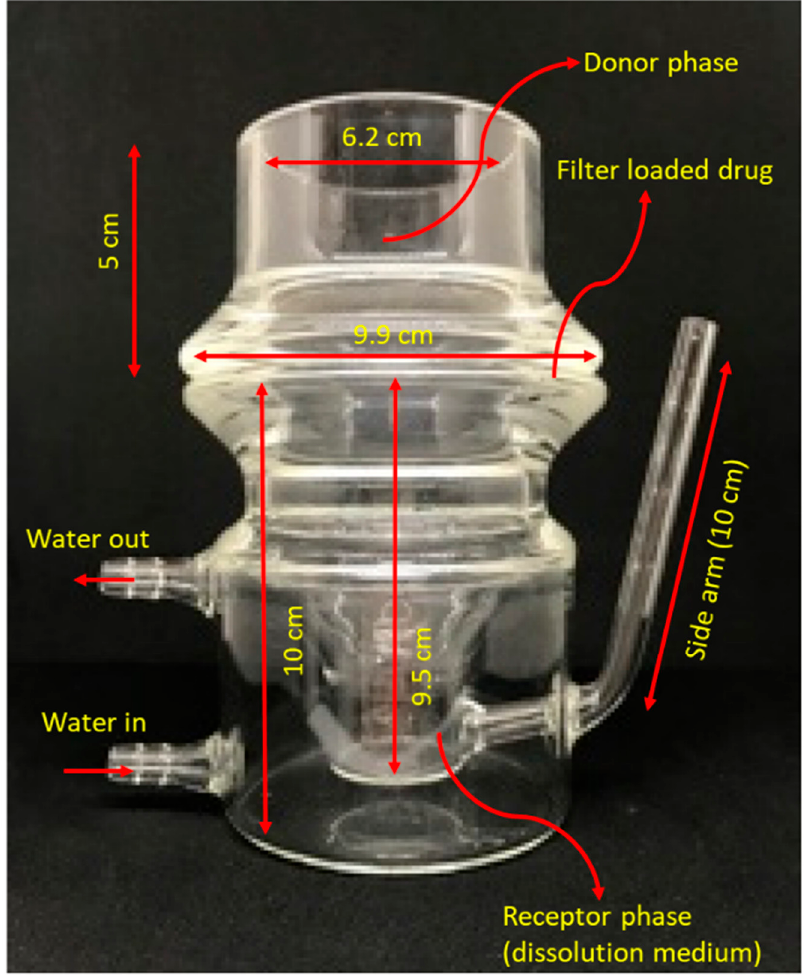
Figure 8. The schematic representation of Respicell (adopted and modi fi ed from